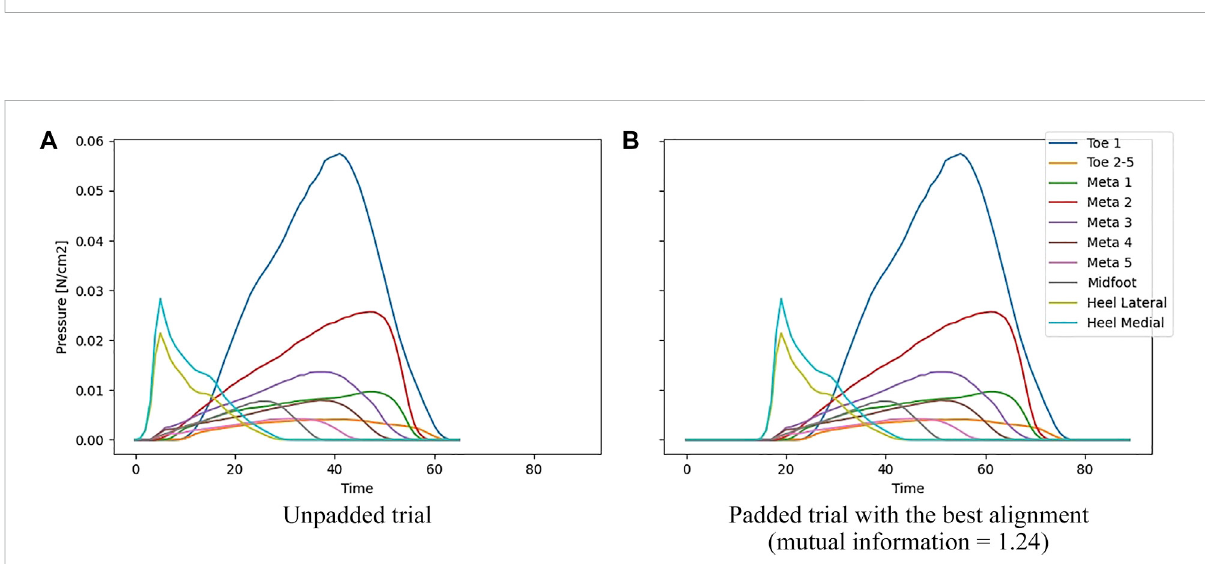
FIGURE 1 Themachine learningpipeline usedto predictlowerextremity overuseinjuries,includingtheevaluationprocess. Evaluationisdone withleave- one-out cross validation. The fi nal results are averaged over the results of each single prediction.